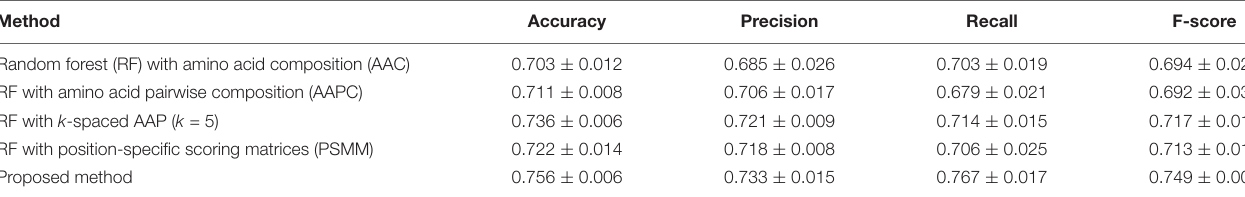
TABLE 3 | Performance comparison between different methods on the testing set.